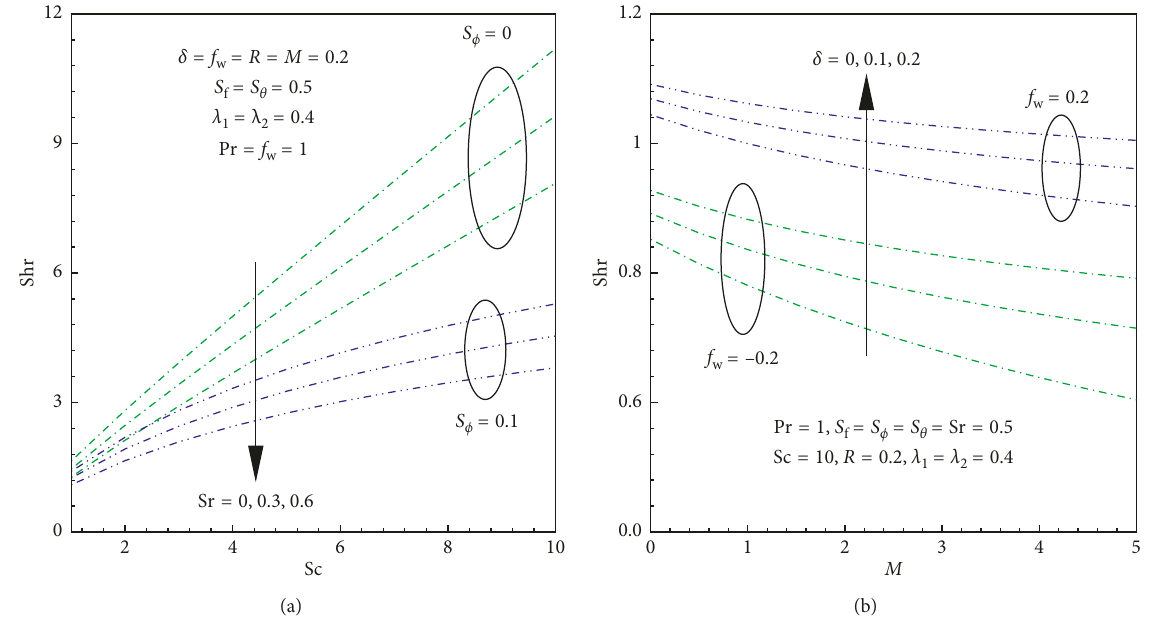
Figure 11: Effects of Sc, Sr,S